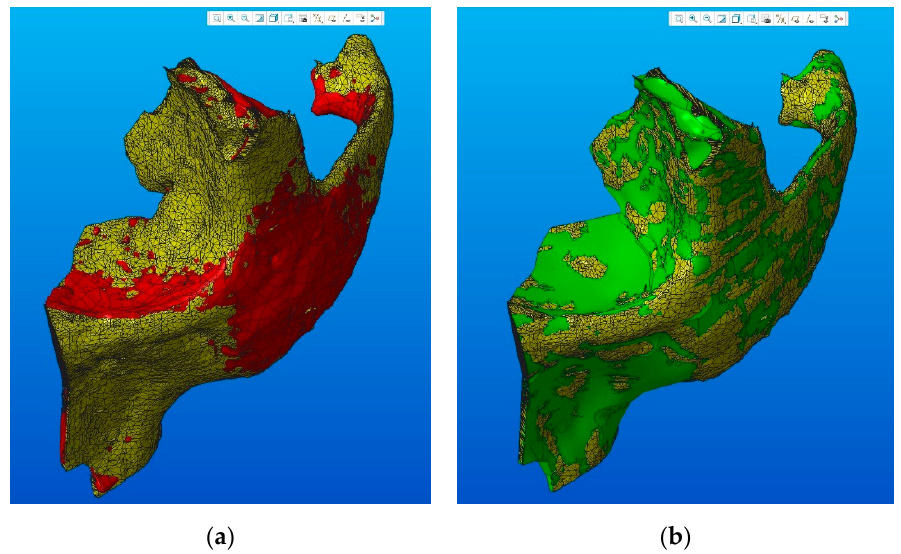
Figure 16. Comparison between generated and initial STL models (in yellow): ( a ) CATIA model; ( b ) Creo model.